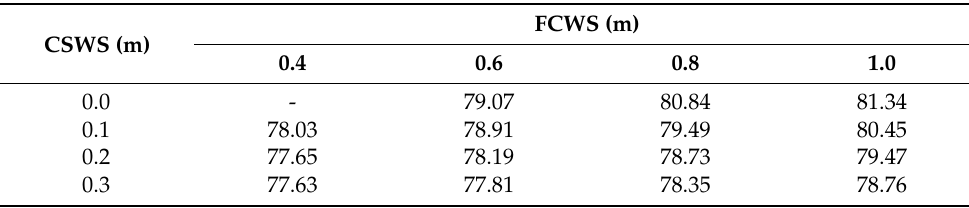
Table 7. The influence of different combinations of CSWS and FCWS on the tree height extraction accuracy ( EA /%) of C. equisetifolia detection.